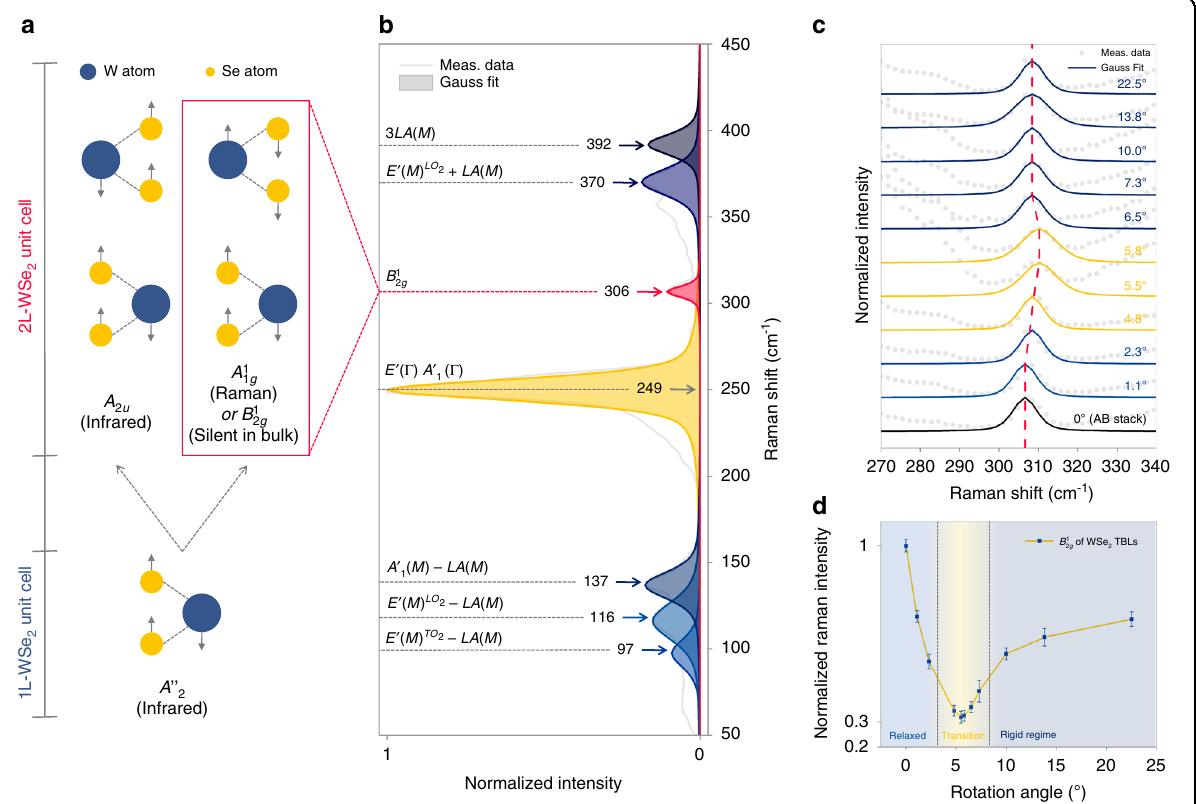
Fig. 4 Interlayer rotation angle dependence of Raman spectroscopy in WSe 2 TBLs. a The origin of B 1 2g mode in the 2H-WSe 2 bilayer. b The normalized spectrum of a WSe 2 bilayer with Raman shifts in the range of 50 to 450 cm − 1 ; the identi fi able Raman modes are highlighted by Gaussian fi tting, and the corresponding symmetry assignments are indicated. c The normalized spectra with Raman shifts in the range of 270 to 340 cm − 1 for WSe 2 TBLs with a series of interlayer rotation angles; the B 1 2g modes are highlighted by Gaussian fi tting; the red dotted line is the visual guide of the B 1 2g Raman shifts evolution. d The twist-angle-dependent B 1 2g Raman intensity